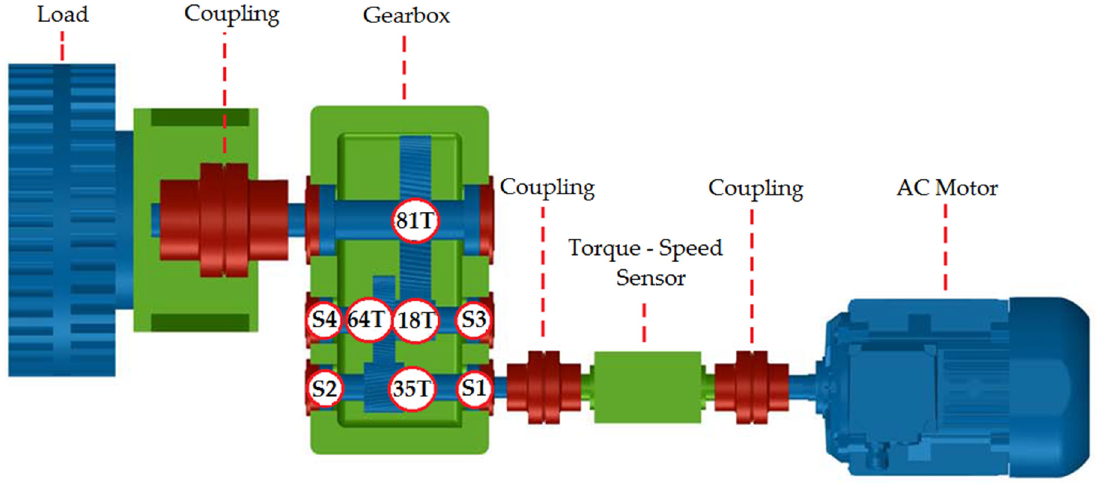
Figure 7. A schematic of the experimental gearbox test rig.